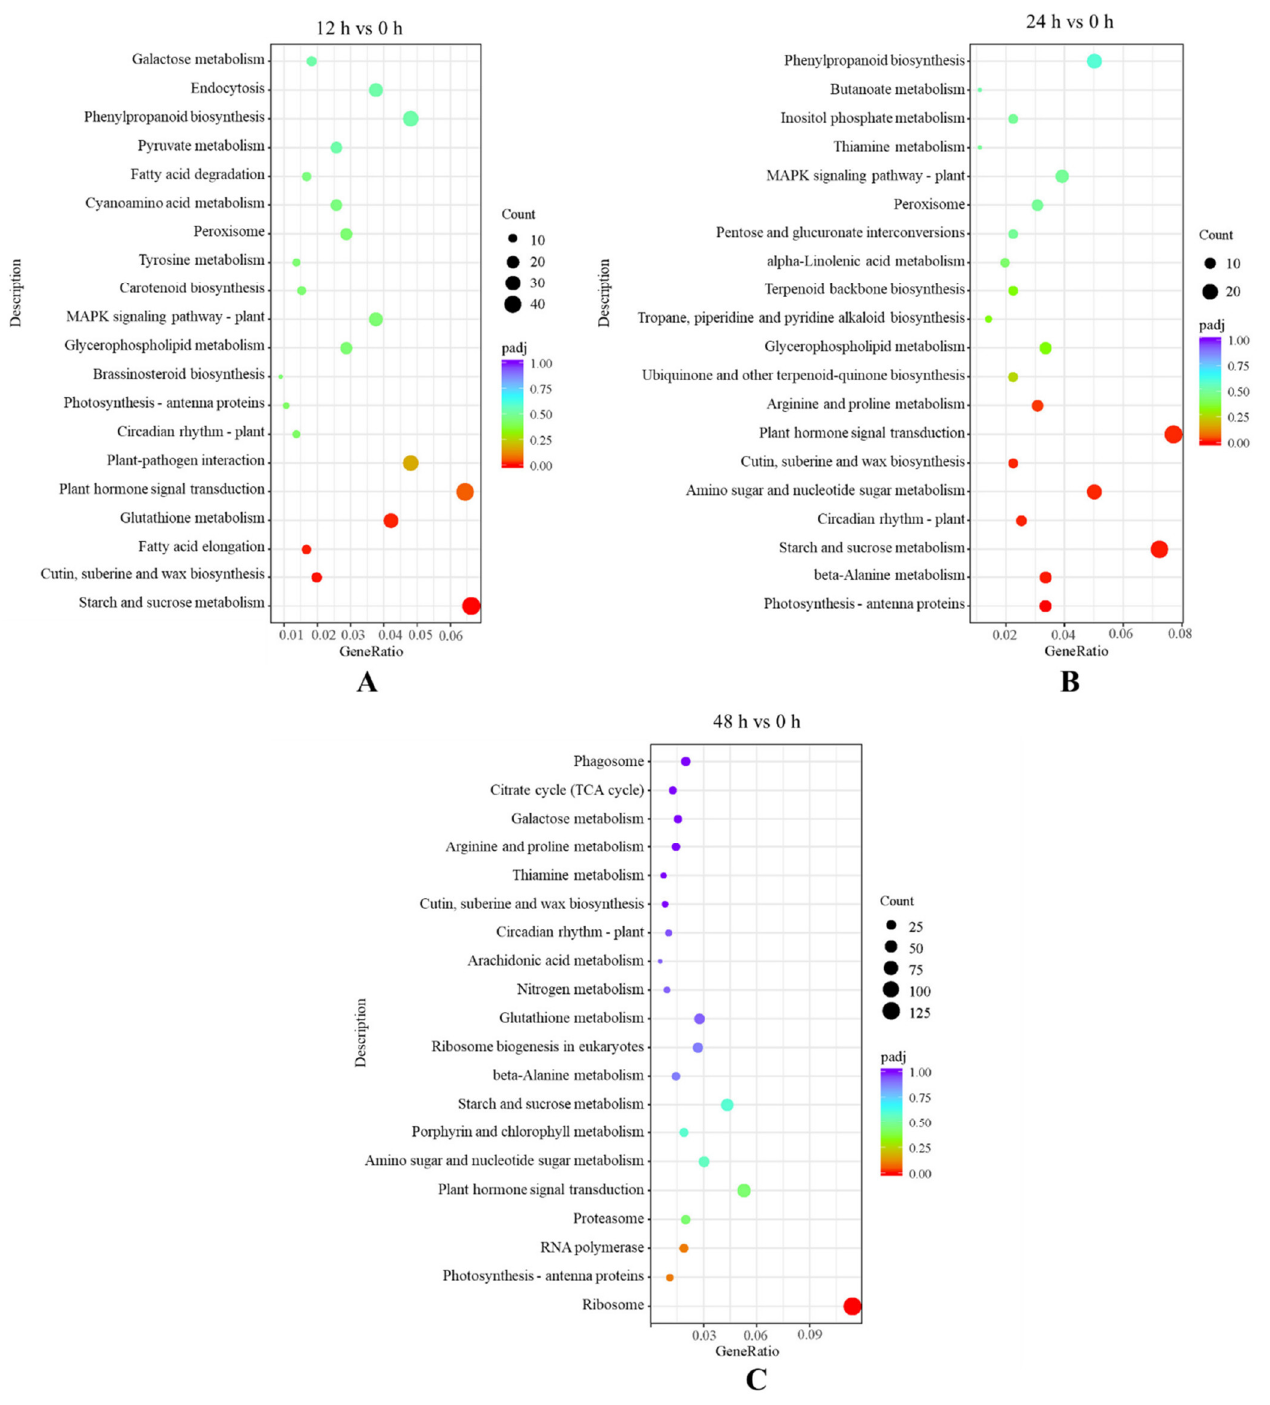
Figure 5. Kyoto Encyclopedia of Genes and Genomes (KEGG) enrichment analysis in the following groups: ( A ) 12 h vs. 0 h; ( B ) 24 h vs. 0 h; ( C ) 48 h vs. 0 h. groups: ( A ) 12 h vs. 0 h; ( B ) 24 h vs. 0 h; ( C ) 48 h vs. 0